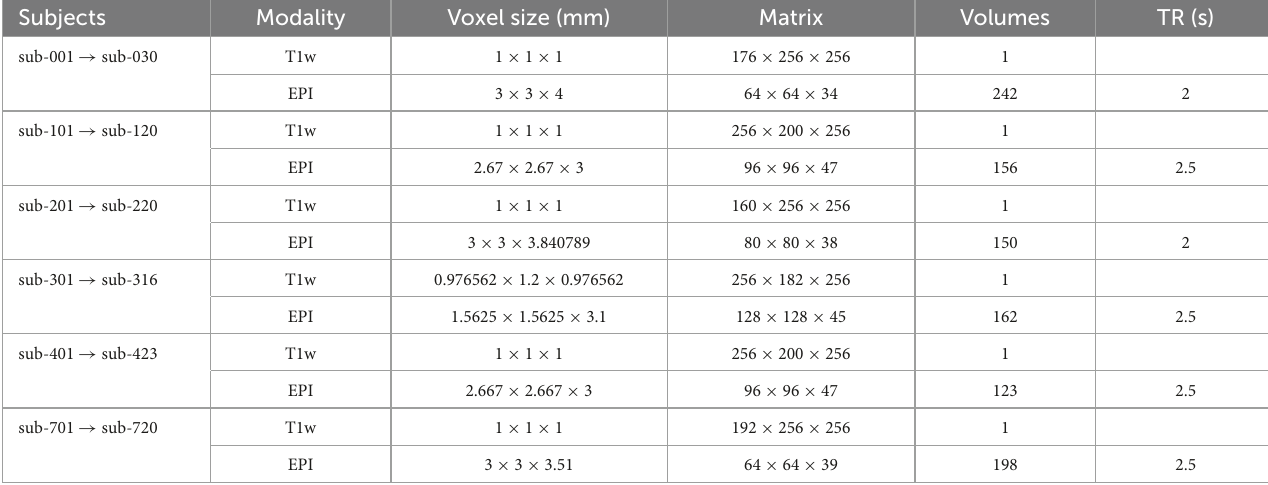
TABLE 1 Expected acquisition parameters for subjects in each site in the main dataset.